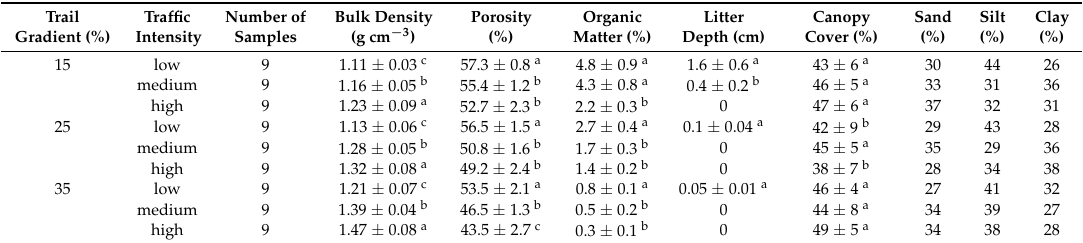
Table 1. Selected soil physical properties before the experiment started in 2015 in the runoff sample